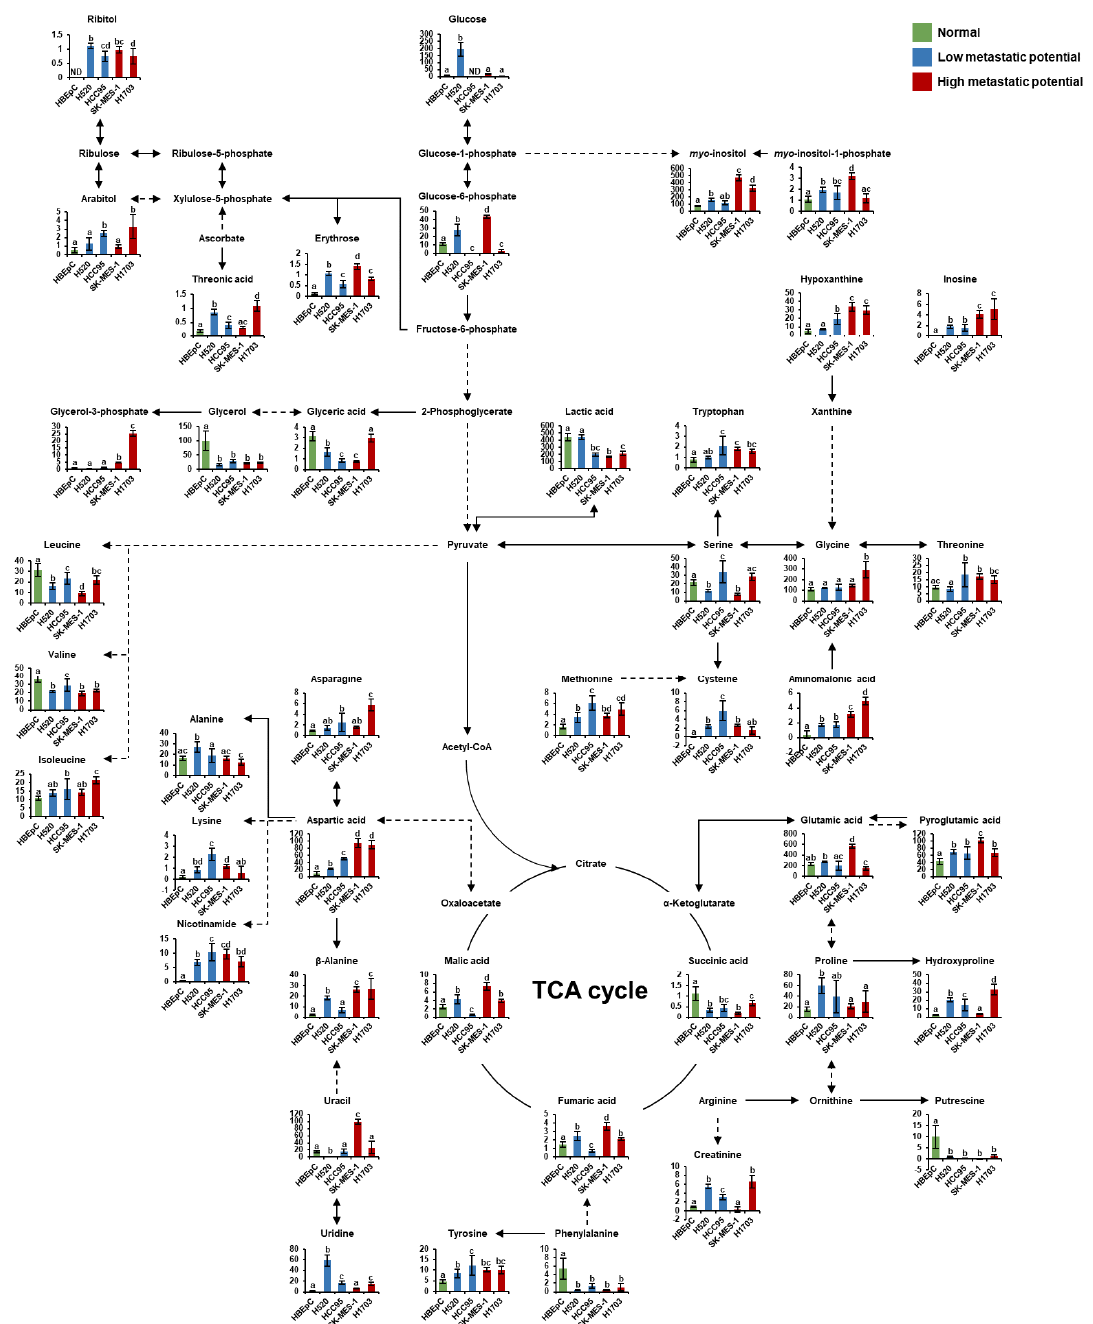
Figure 5. Schematic of metabolism in human bronchial epithelial cells (HBEpC) and four lung squamous cell carcinoma cell lines (H520, HCC95, SK-MES-1, and H1703). The indicated metabolism was modified from the KEGG database (http://www.genome.jp/kegg/ accessed on 5 March 2021). The metabolites on the pathway were selected by associated pathway analysis using Metaboanalyst and each PLS-DA model with a VIP value over 1.0. Each graph shows mean values with error bars indicating standard deviation (SD) ( n = 8, four biological replicates, and two technical replicates for each group). The Y -axis of each data represents the normalized peak intensity. Significant differences were evaluated using ANOVA with a Tukey’s post hoc test, and different letters (a, b, c, and d) represent statistically significant differences of relative levels of each metabolite among samples ( p < 0.05). Relative levels of each metabolite were represented with different colors according to the cell’s metastatic potential (green, normal cells; blue, low-metastatic potential of lung SQCC; red, high-metastatic potential of lung SQCC). TCA; tricarboxylic